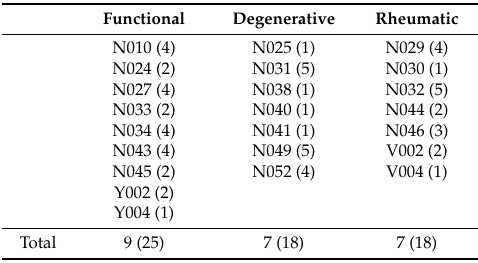
Table 1. Patient code divided in categories and number of CT specimens excised from each